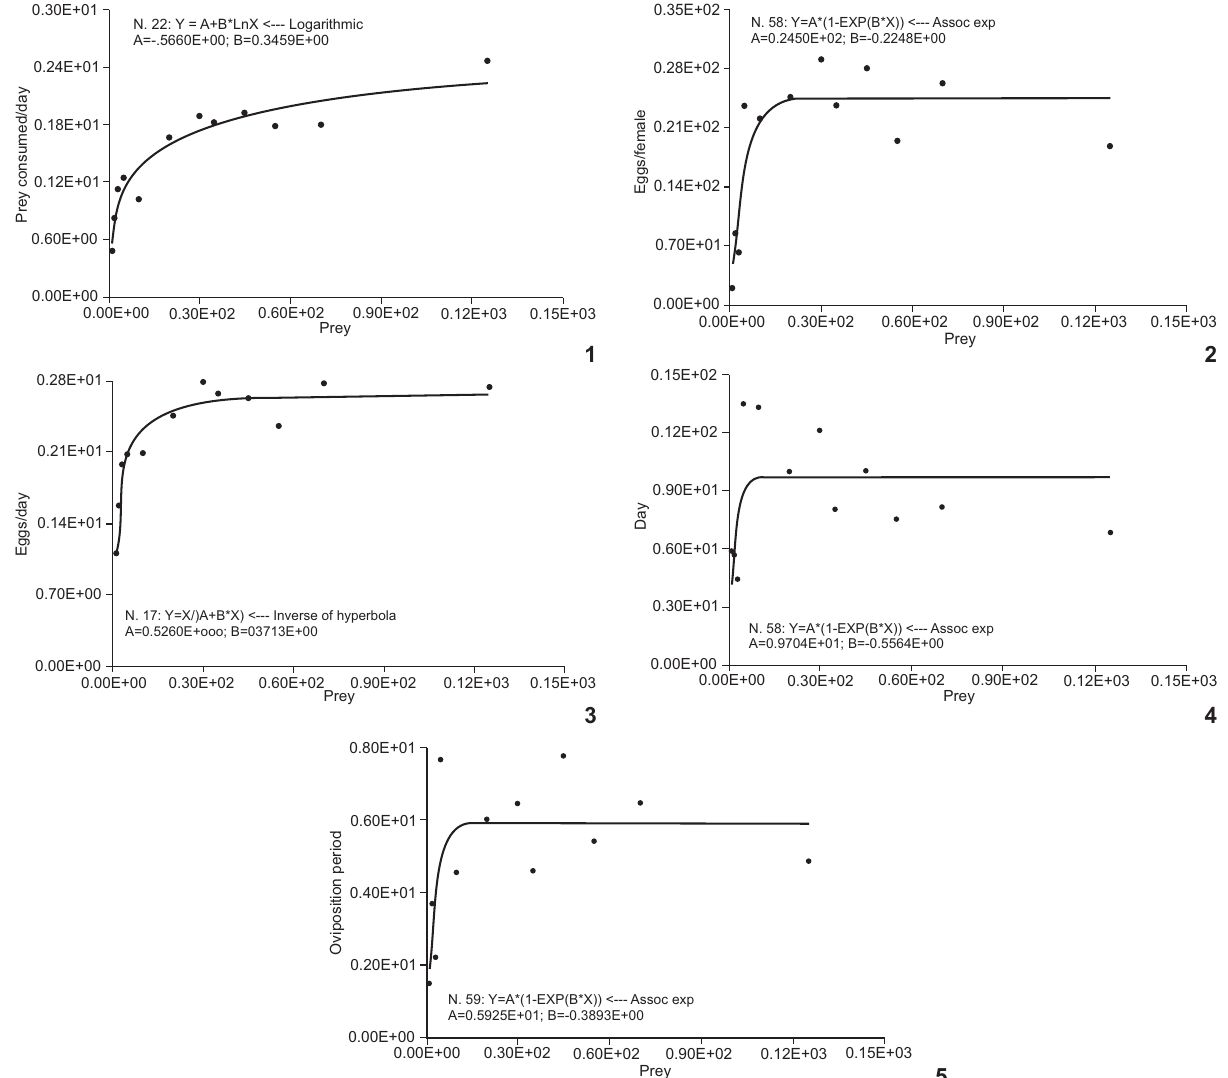
Figures 1-5.Curve fitting of the functional response and Pearson correlation of P. macropilis in presence of different density of T. urticae at 25 ± 1ºC, 12 hours photophase and 80 ± 5% relative humidity: (1) prey consumed/day; (2) eggs/female; (3) oviposition days; (4) longevity; (5) oviposition